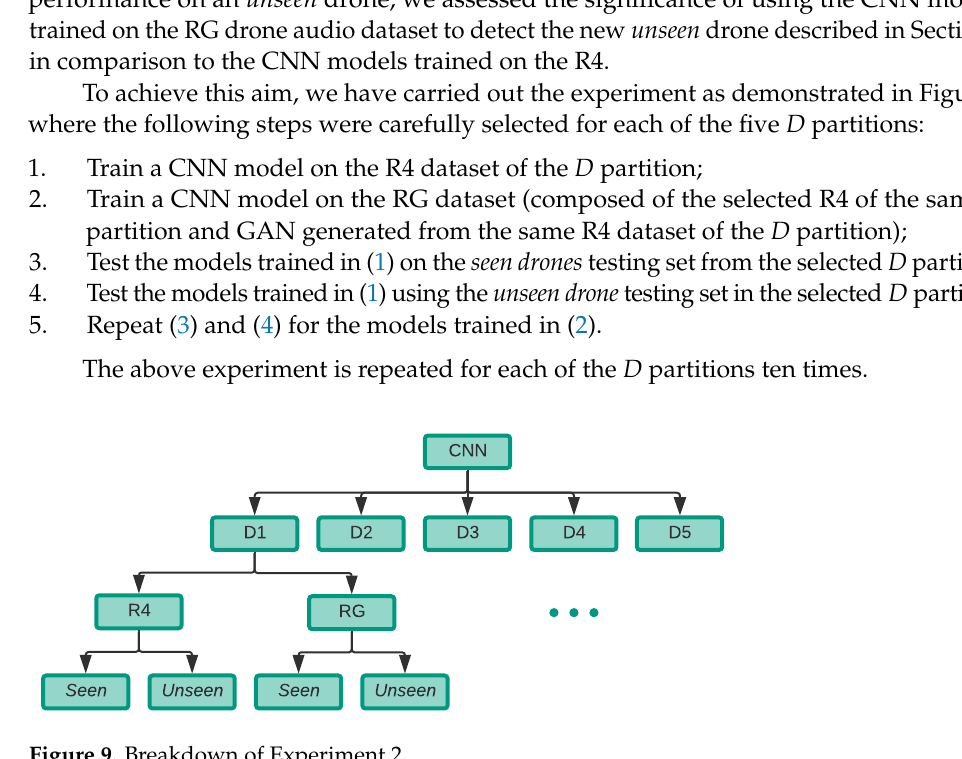
Figure 9. Breakdown of Experiment